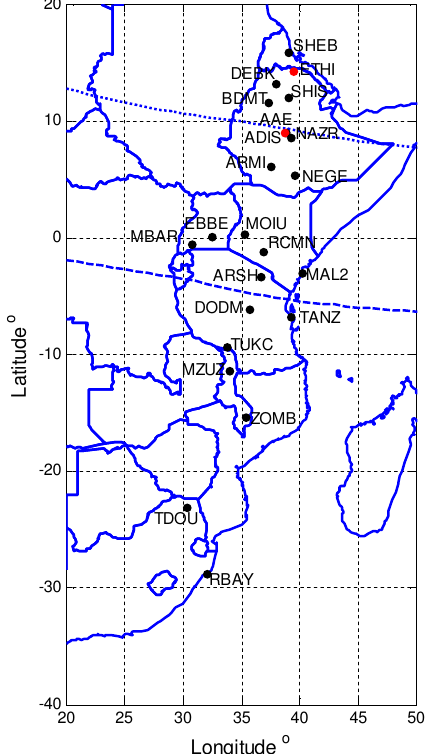
Figure 1. A map showing data sites. The red and black dots indi- cate the locations of the magnetometers and the UNAVCO stations, respectively. The dotted and dashed lines represent the magnetic equator and the southern crest of the EIA,